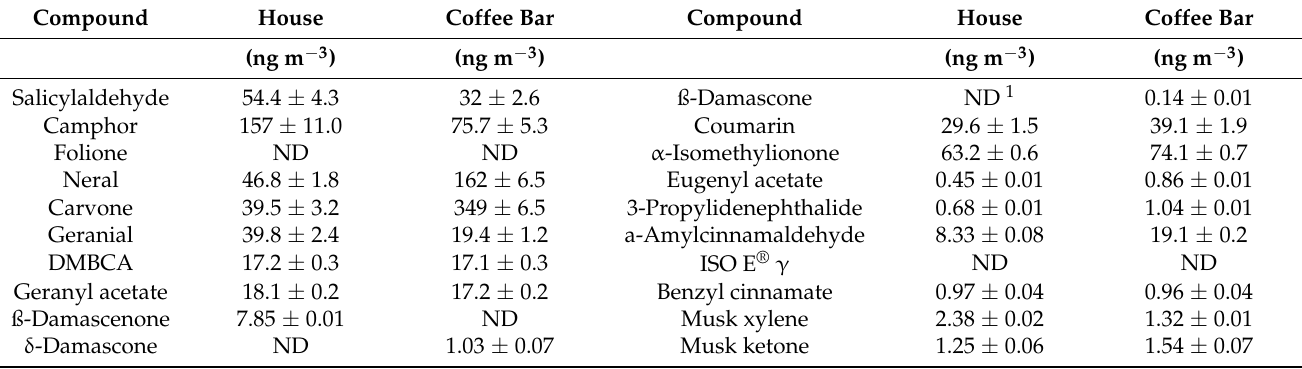
Figure 3. SIM-B chromatogram of the sample collected in the coffee bar. Table 4. Concentration (ng m − 3 ) of fragrances collected in the house and in the coffee